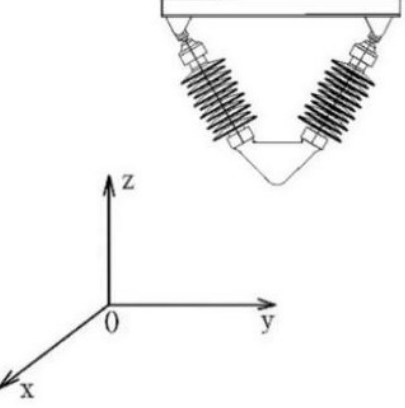
Figure 4. Coordinate system of the insulator